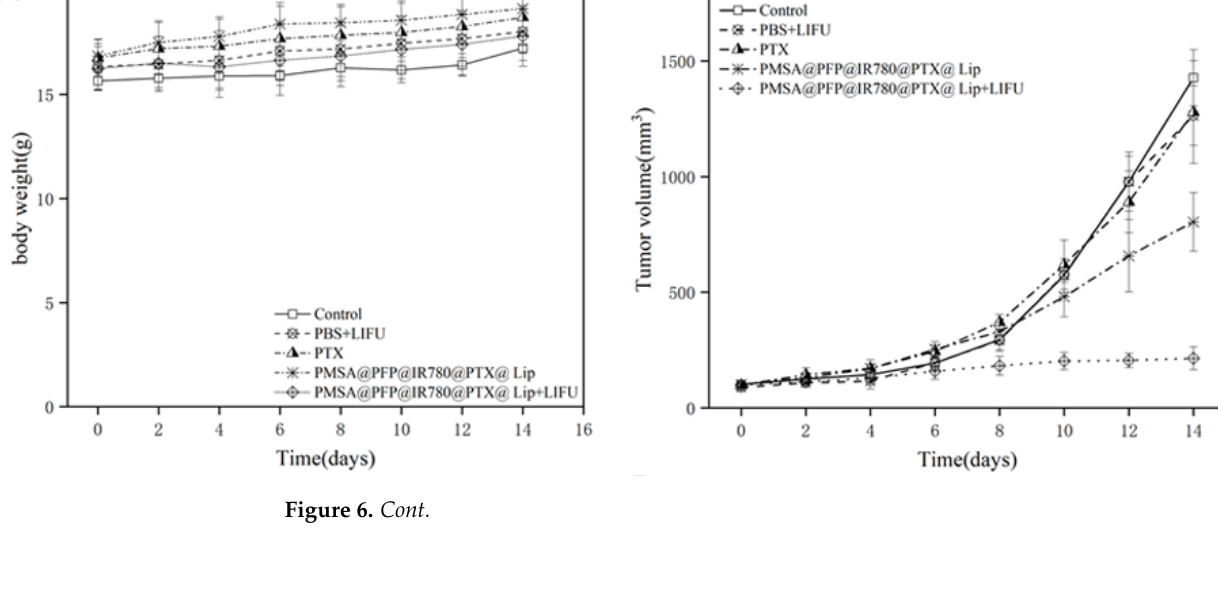
Figure 6. Antitumor efficacy of NPs in vivo: ( A ) body weight, ( B ) tumor volume, ( C ) cumulative survival of animals, and ( D ) tumor weight of nude mice subjected to different treatments. Error bars represent the means ± SD for n = 3.